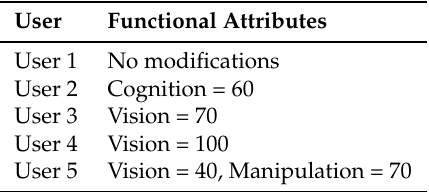
Table 7. Users & Functional attributes.